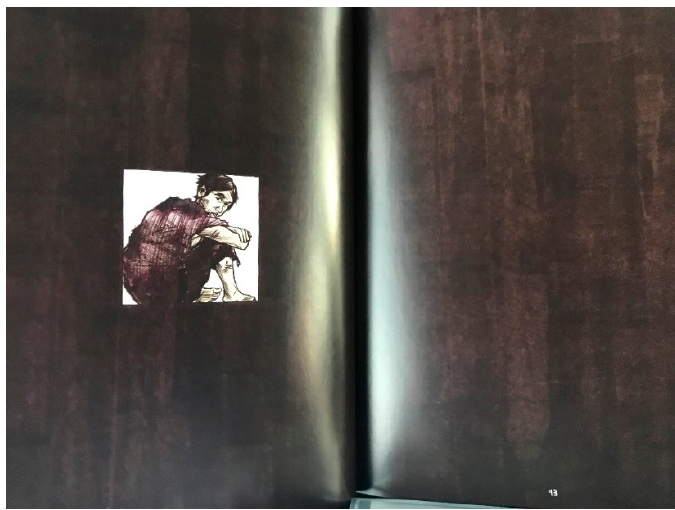
Figure 3. A squared liminal space caged a person’s mind and soul without a light of hope.